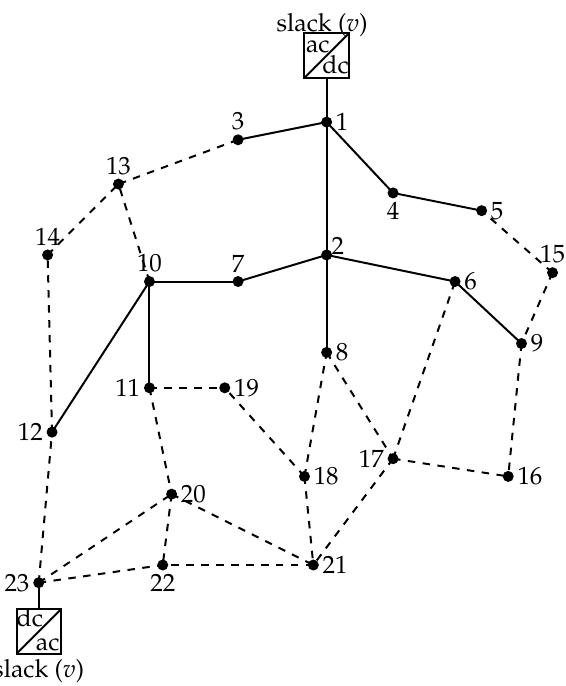
Figure 3. Electrical configuration for the 23-nodes test feeder.